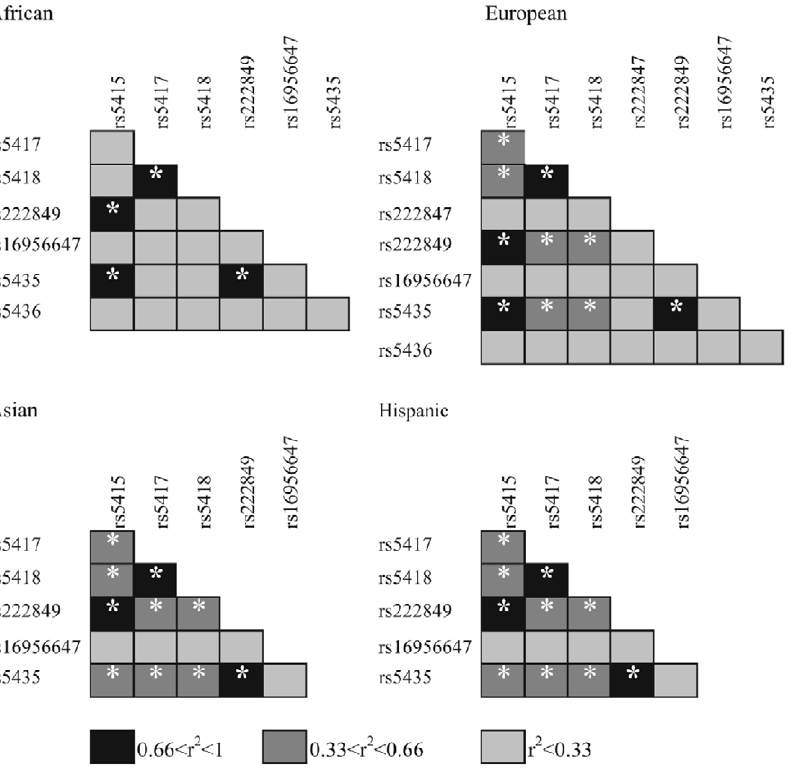
Figure 3. Pairwise linkage disequilibrium in SLC2A4 in human populations as ascertained in the re-sequencing panel. Significant r 2 values (LOD . 2) are denoted by white asterisks.